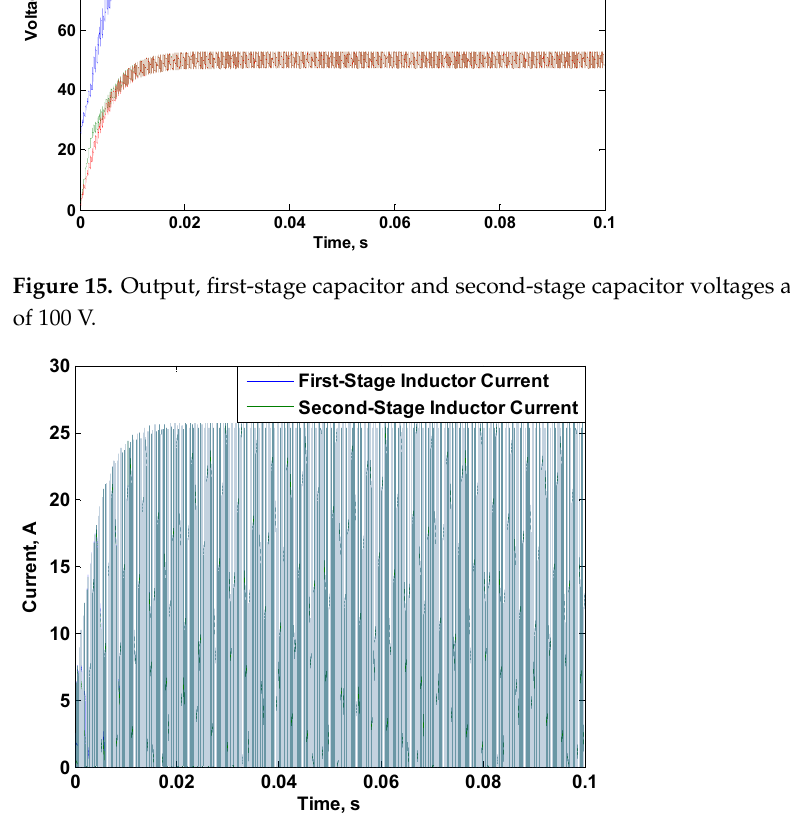
Figure 17. Output, first-stage capacitor and second-stage capacitor voltages at a reference voltage of 200 V.